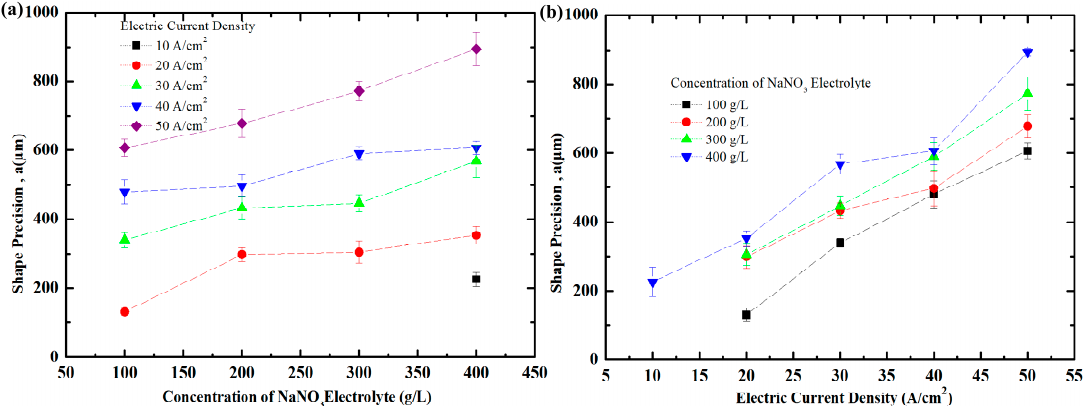
Figure 19. ( a ) Shape precision at different concentration in NaNO 3 electrolyte; ( b ) Shape precision at different current density in NaNO 3 electrolyte.